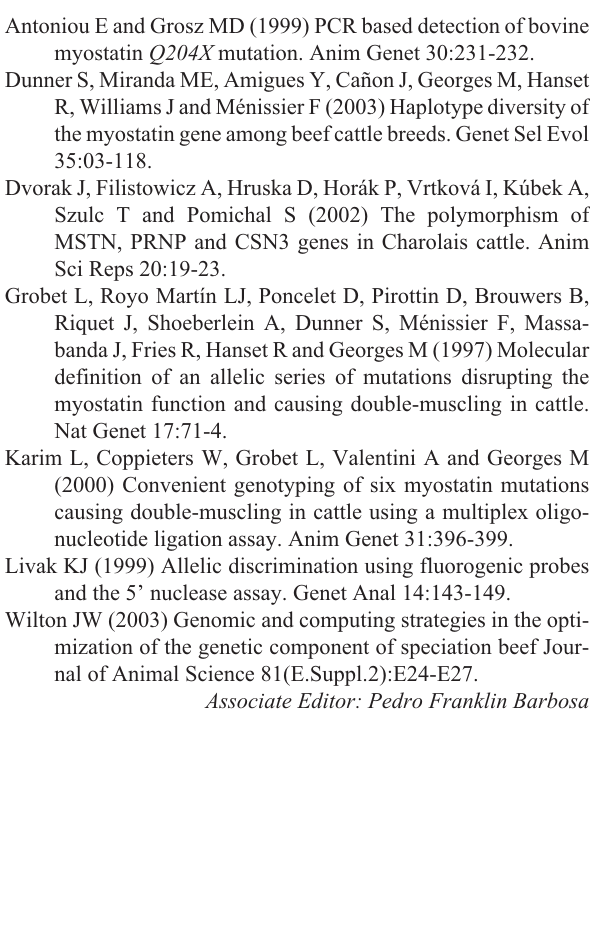
Genotype frequency (%) Allele frequencies